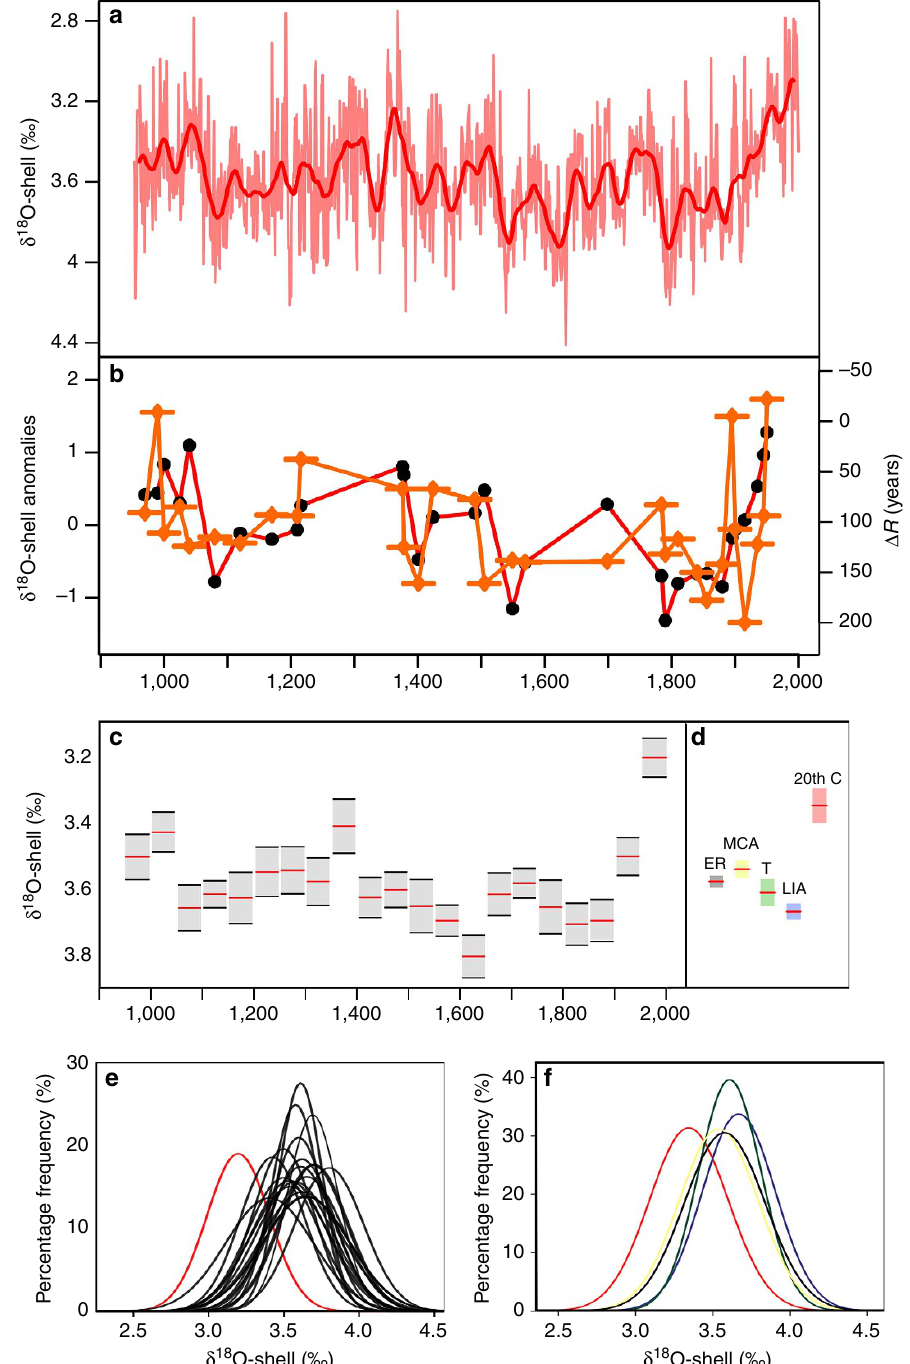
Figure 2 | The d 18 O-shell series and D R record. ( a ) The annually resolved d 18 O-shell series (pink line) plotted with a 30-year loess first-order low-pass filter (thick red line). ( b ) The North Icelandic marine reservoir age series 21 (orange line with diamonds and bar) and the d 18 O-shell values for the corresponding years (red line with black dots). The d 18 O-shell series was low-pass filtered to match the temporal resolution of the D R record. ( c ) Mean d 18 O-shell values plotted with associated 95% confidence intervals calculated over 50-year bins (with zero years overlap) and ( d ) mean d 18 O-shell values calculated over the twentieth century (20th C; red bar), the Little Ice Age (LIA; blue bar), the MCA-LIA transition (T; green Bar), the Medieval Climate Anomaly (MCA; yellow bar) and the entire isotope record (ER; grey bar). ( e , f ) Percentage frequency distributions of the d 18 O-shell record calculated over ( e ) 50-year bins (red line corresponds to 1951–2000, whereas the black lines correspond the previous 50-year bins) and ( f ) the twentieth century (red line), the Little Ice Age (blue line), the MCA-LIA transition (green line), the Medieval Climate Anomaly (yellow line) and the entire isotope record (black